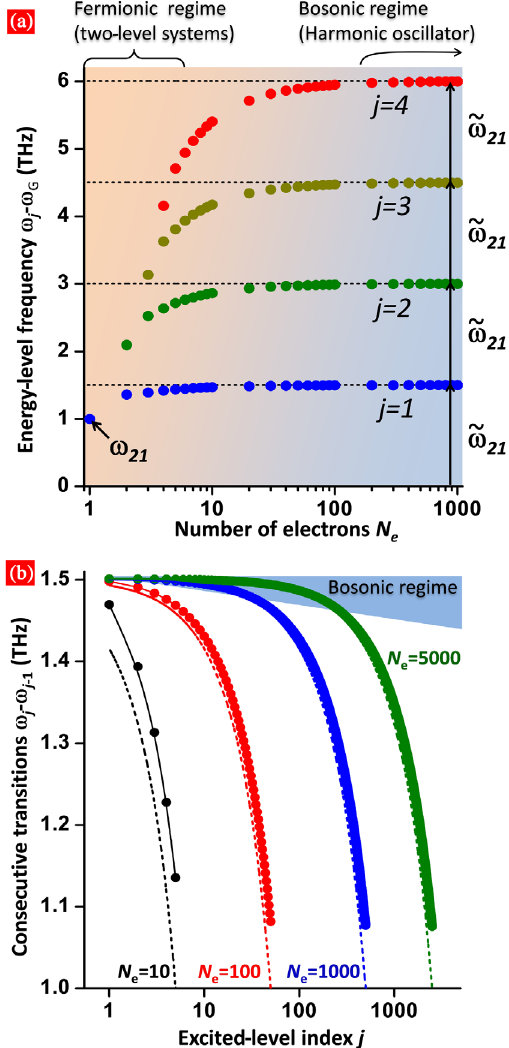
FIG. 4. (a) Frequencies of the first four many-body states of the 2DEG, above the ground state, as a function of the total number of electrons in the system N e . The areal density is fixed at =S ¼ 5 × 10 10 cm − 2 . As the number of electrons is increased, N e the first levels become equally spaced with a separation ffiffiffiffiffiffiffiffiffiffiffiffiffiffiffiffiffiffiffiffiffiffiffiffiffiffi p ~ ω ω 2 ω 2 N . (b) Value of the frequency spacing Δ ω j ¼ 21 ¼ e 21 þ P 1 ω − ω j j − 1 as a function of the number of electrons second subband, for different values of N e . The dashed lines are the prediction of the formula ~ ω 21 ð j Þ